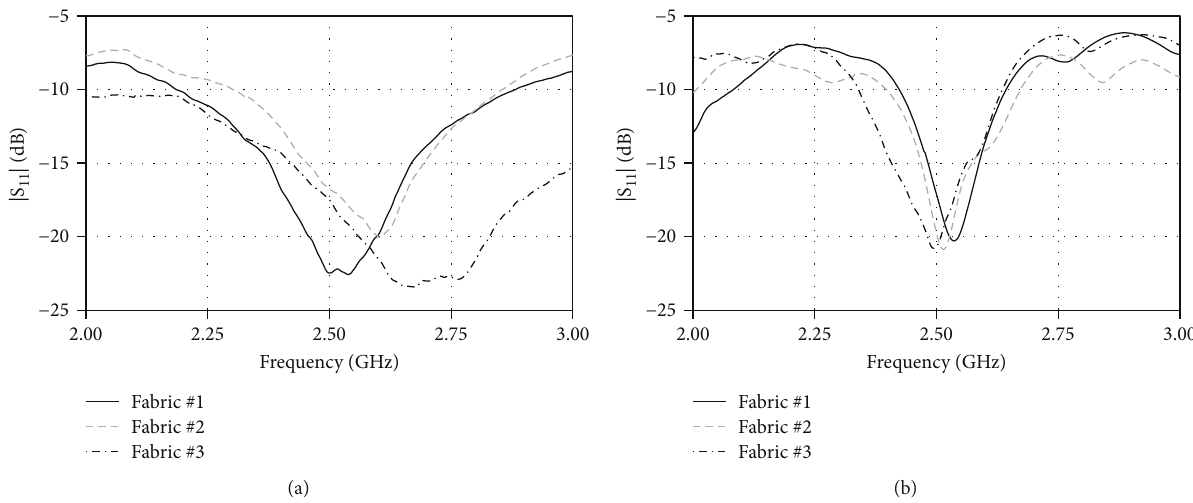
fl ector; (b) with re fl